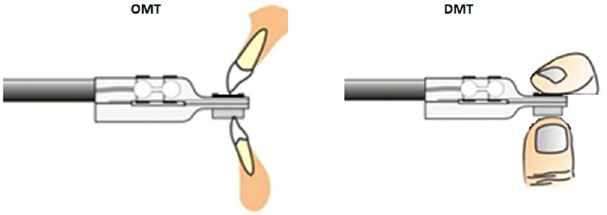
Figure 1. Schematic representation of an oral motor task (OMT) and digital motor task